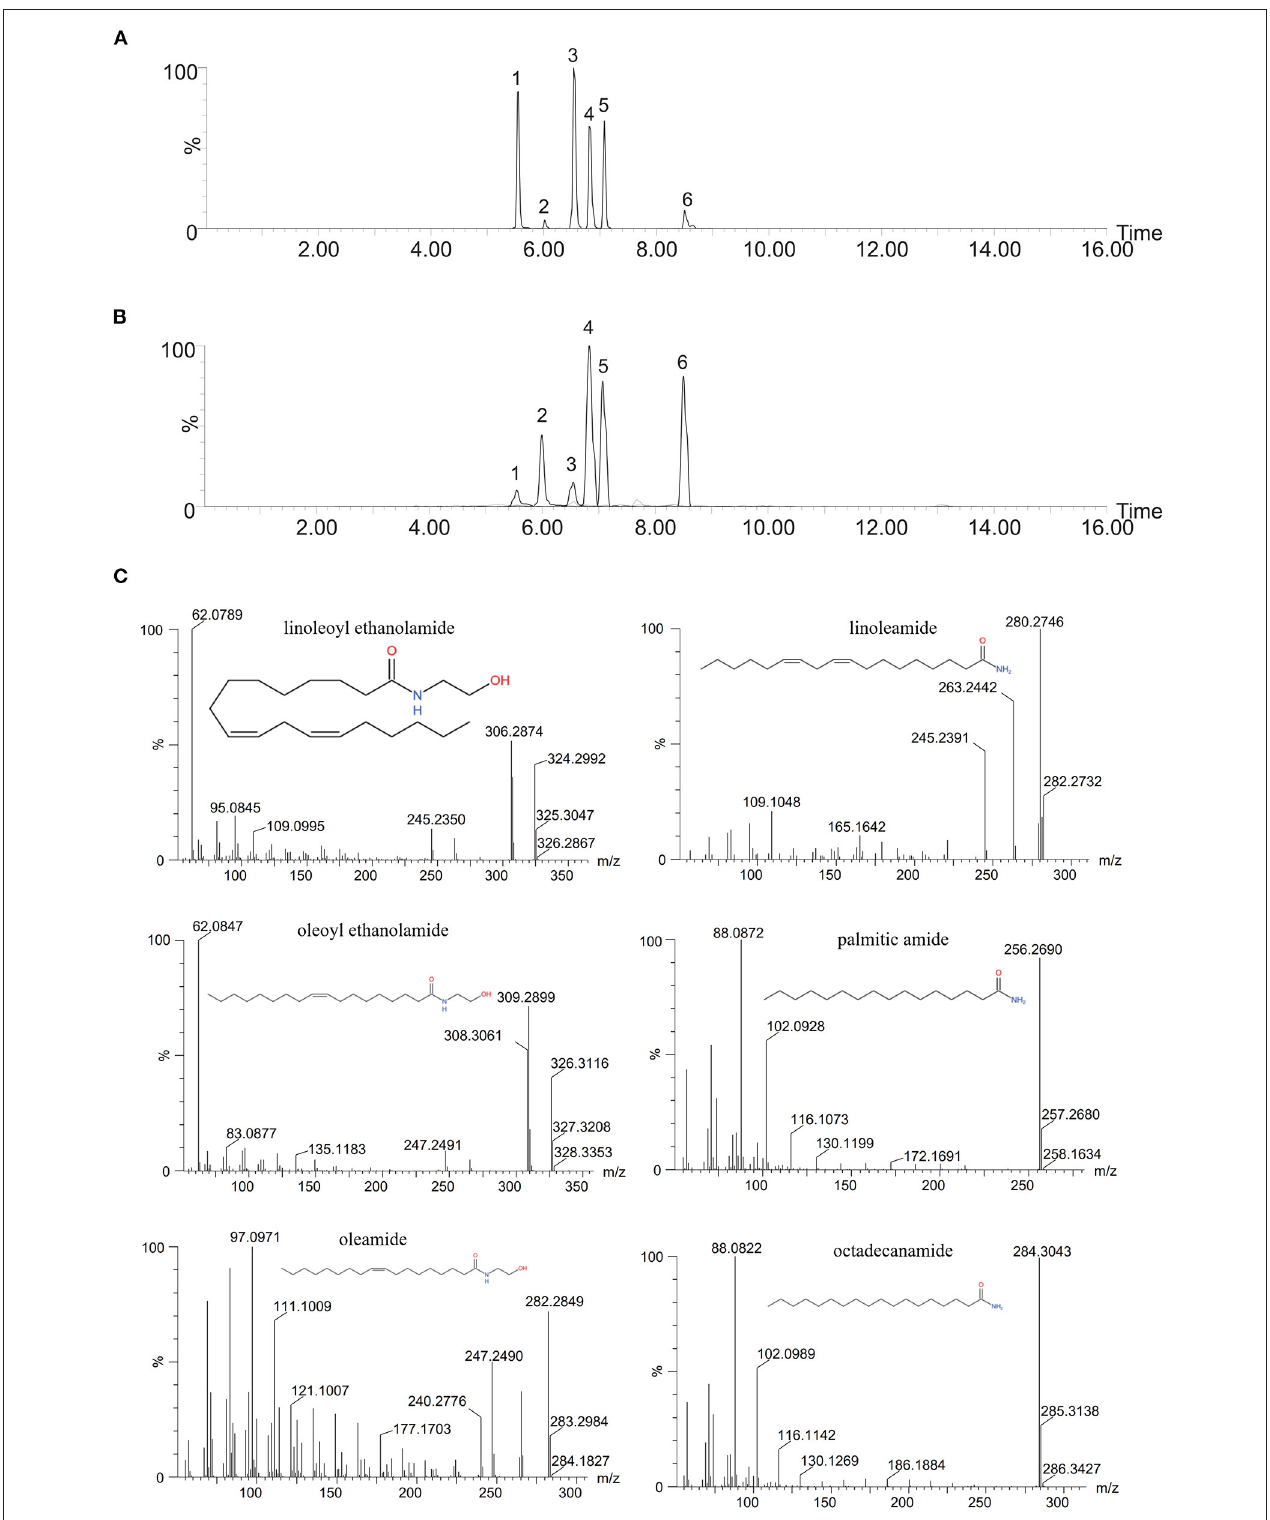
FIGURE 1 | Base peak intensity ion chromatograms and MSMS spectra of six FAAs in standard solution and vegetable oil. (A) Six FAAs in standard solutions; (B) six FAAs in sesame oil. 1: Linoleoyl ethanolamide, 2: linoleamide, 3: oleoyl ethanolamide, 4: palmitic amide, 5: oleamide, 6: octadecanamide. (C) MSMS spectra.